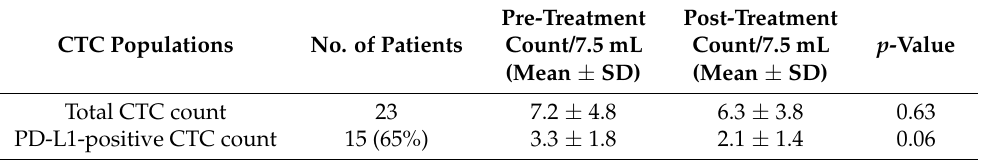
Table 2. Enriched baseline circulating tumor cell (CTC)